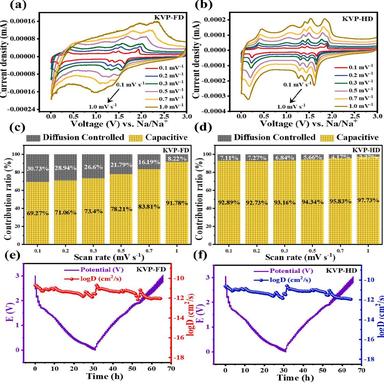
(a-b) CV profiles at various scan rates, (c-d) k1 coefficient with various scan rates, (e-f) GITT & DNa + /K coefficient vs V when charging/discharging the KVP-FD and KVP-HD electrodes.